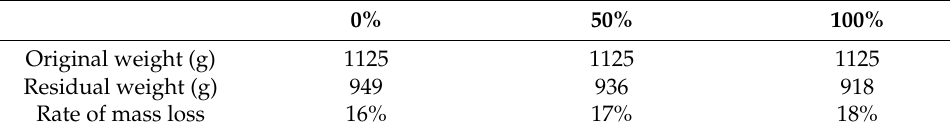
Table 3. Mass loss rate of lithium iron phosphate battery in eruption